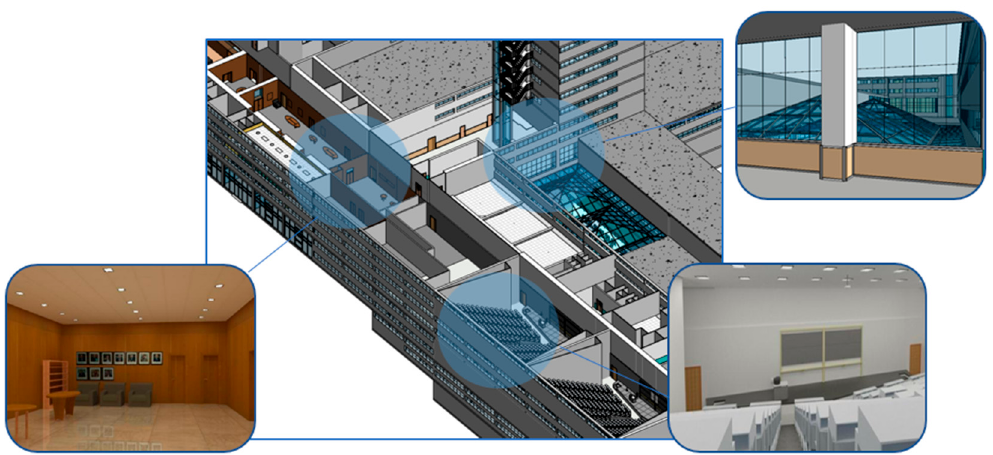
Figure 9. High detailed locations.